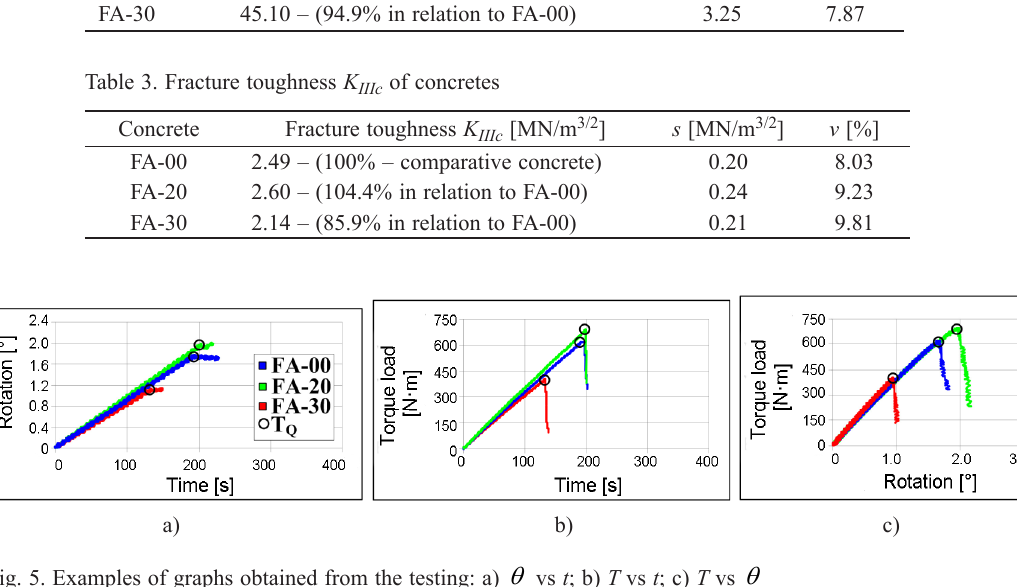
Fig. 5. Examples of graphs obtained from the testing: a) θ vs t ; b) T vs t ; c) T vs θ